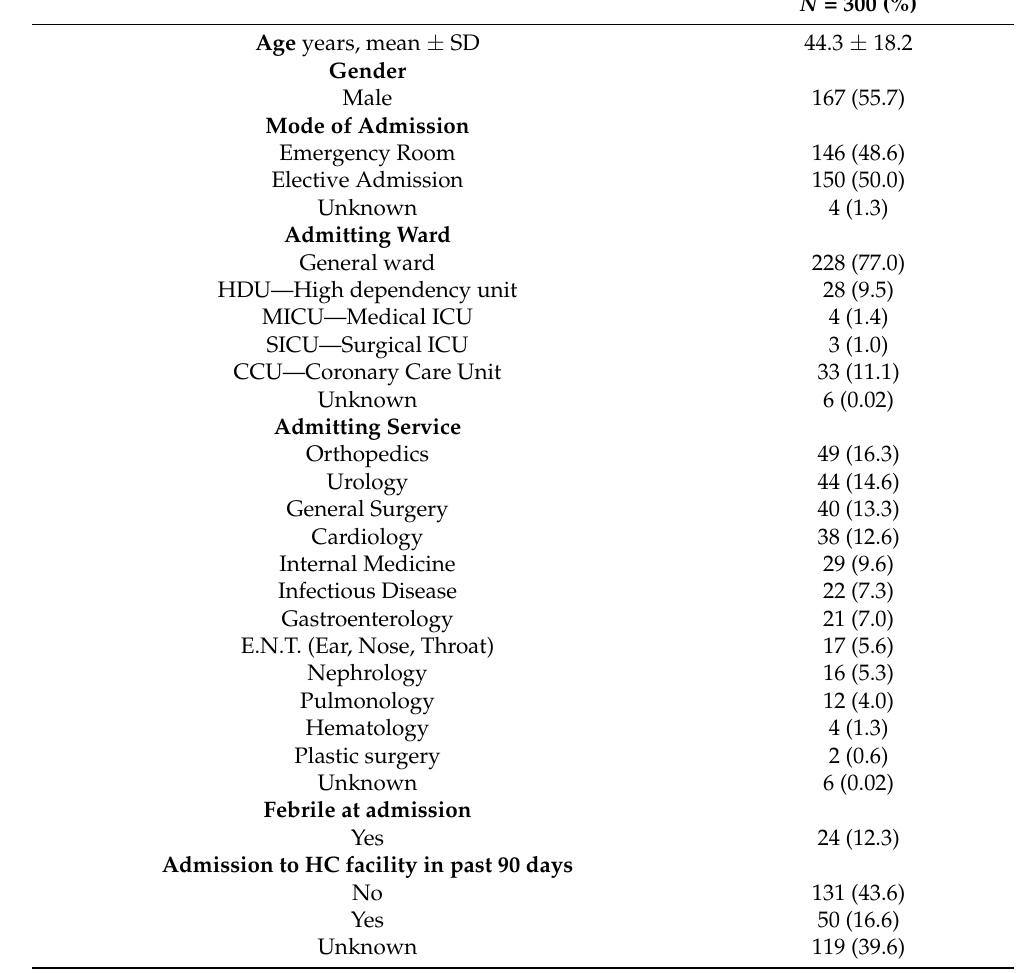
Table 1. Demographic and clinical details of participants at